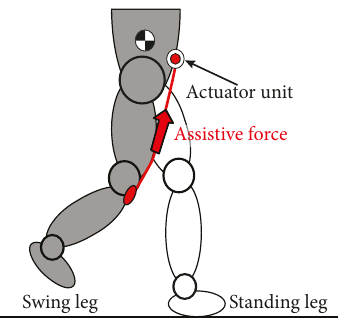
Figure 2: Assistance motion for the swing